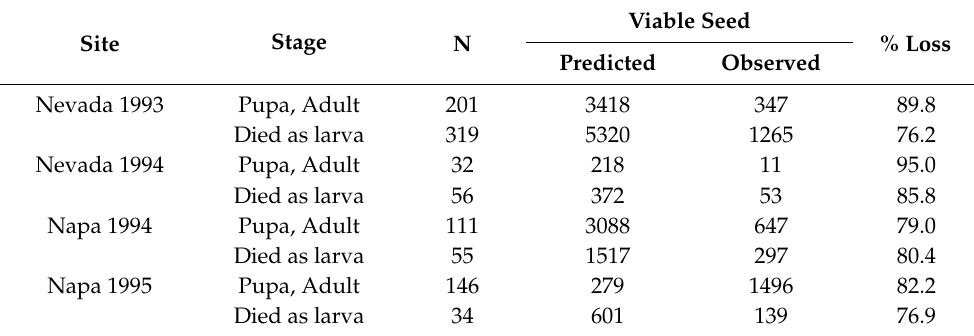
Table 7. Observed (with Eustenopus villosus ) and predicted (without E. villosus ) seed production and percent seed loss for Centaurea solstitialis capitula where E. villosus larvae completed larval development and where larvae died immature. N = number of